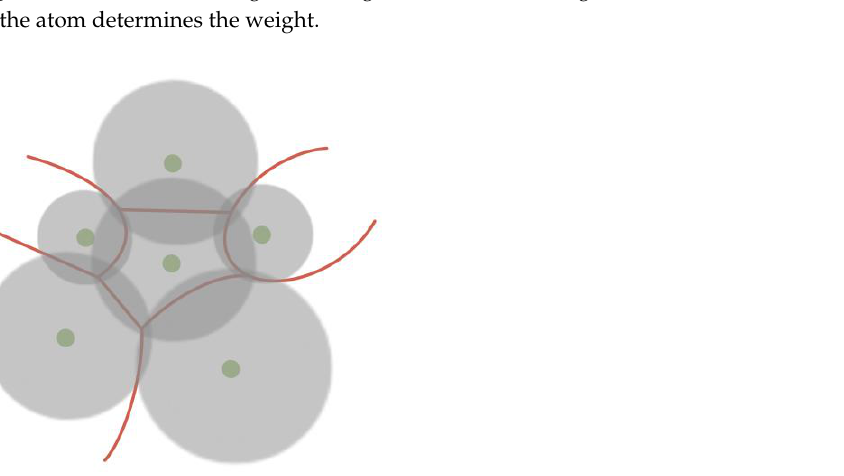
Figure 19. The structure of beta-purothionin in the form of a 3D Voronoi diagram, which was built taking into account weighting factors [59]. 3.8. Trilinear Coordinate Model A trilinear coordinate model can be used to display relative data. An example of tri- linear coordinates is the United States Department of Agriculture’s soil texture triangle, which is used to define soil types. Robert Bruce Whitaker developed this idea by